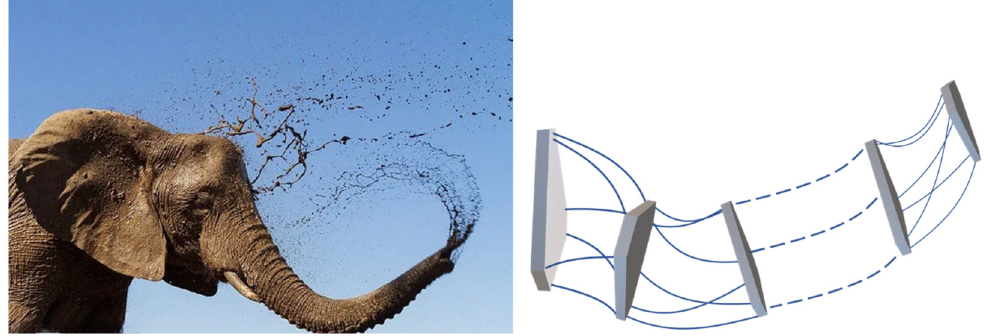
Figure 1. Elephant trunk robot based on flexible series-parallel structure.